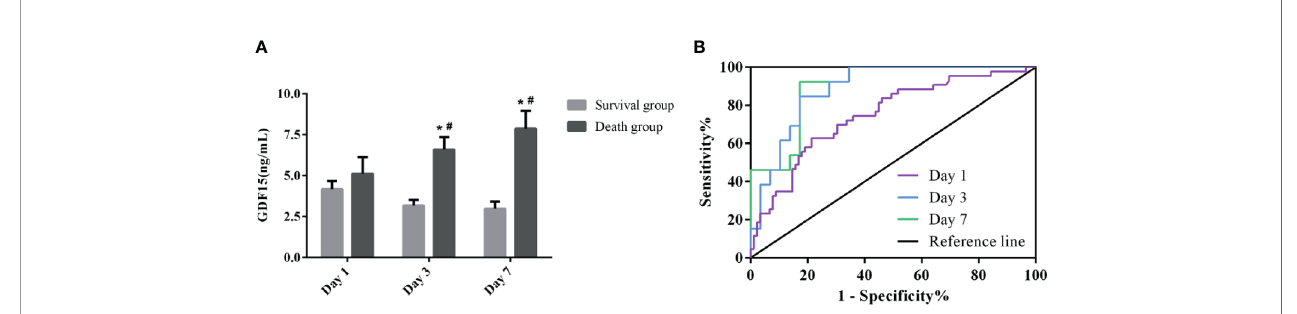
FIGURE 6 | Dynamic analysis of GDF15 in survival group and death group. (A) : the dynamic changes of GDF15 levels in survival group and death group; (B) : ROC curve of dynamic changes of GDF15 on prognosis of sepsis. * P < 0.05, compare with the same day of survival group; # P < 0.05, compare with Day 1 of the same group.